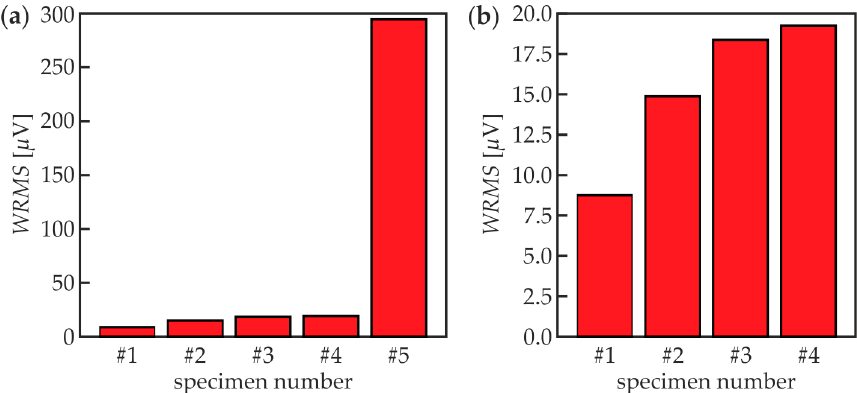
Figure 8. Weighted root mean square (WRMS) values of experimental signals collected in P5 point: ( a ) specimens #1–#5 and ( b ) specimens #1–#4. specimens #1–#5 and ( b ) specimens